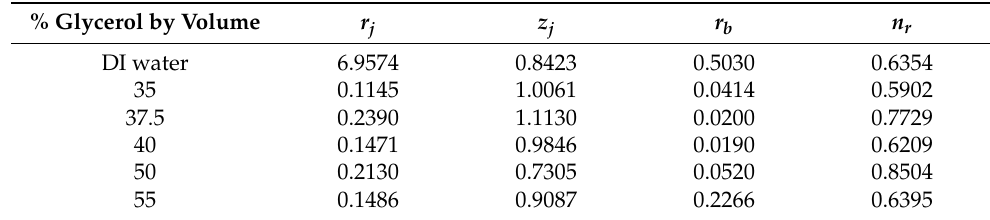
Figure 5. ( a ) Droplet profiles detailing jet evolution versus time with no scaling applied, ( b ) same droplet evolution but with scaling applied to show curve collapse. The 35% G solution ( Oh = 0.0077, U i = 0.5943 m/s, We = 15.2, Re = 504.3). Time between curves is 0.091 ms. Table 2. Average scaling factor of the power law fit for each G+W solution extracted by nondimen- sionalization of droplet profiles for solutions of medium